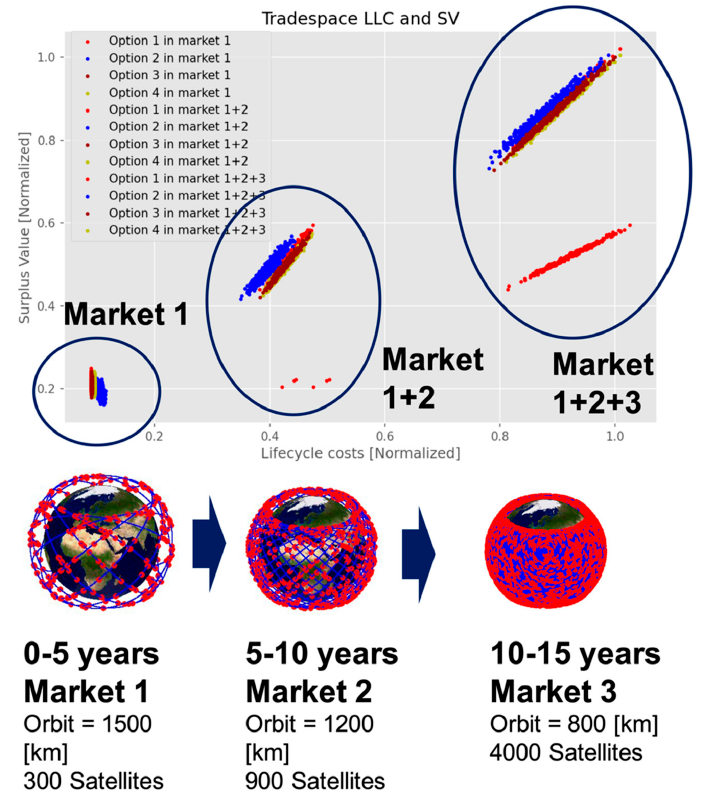
Figure 8. Tradespace between surplus value and lifecycle costs for the different options, considering the transitions between the different markets (500 simulations). The data regarding SV and LCC have been normalized. The positions of the satellites in the lower part of the figure are only demonstrative. Please note that ‘0–5 years’ for Market 1 means that the model considers the start of the business in a stochastic way (i.e., Market 1 starts randomly between 0 and 5 years from today).